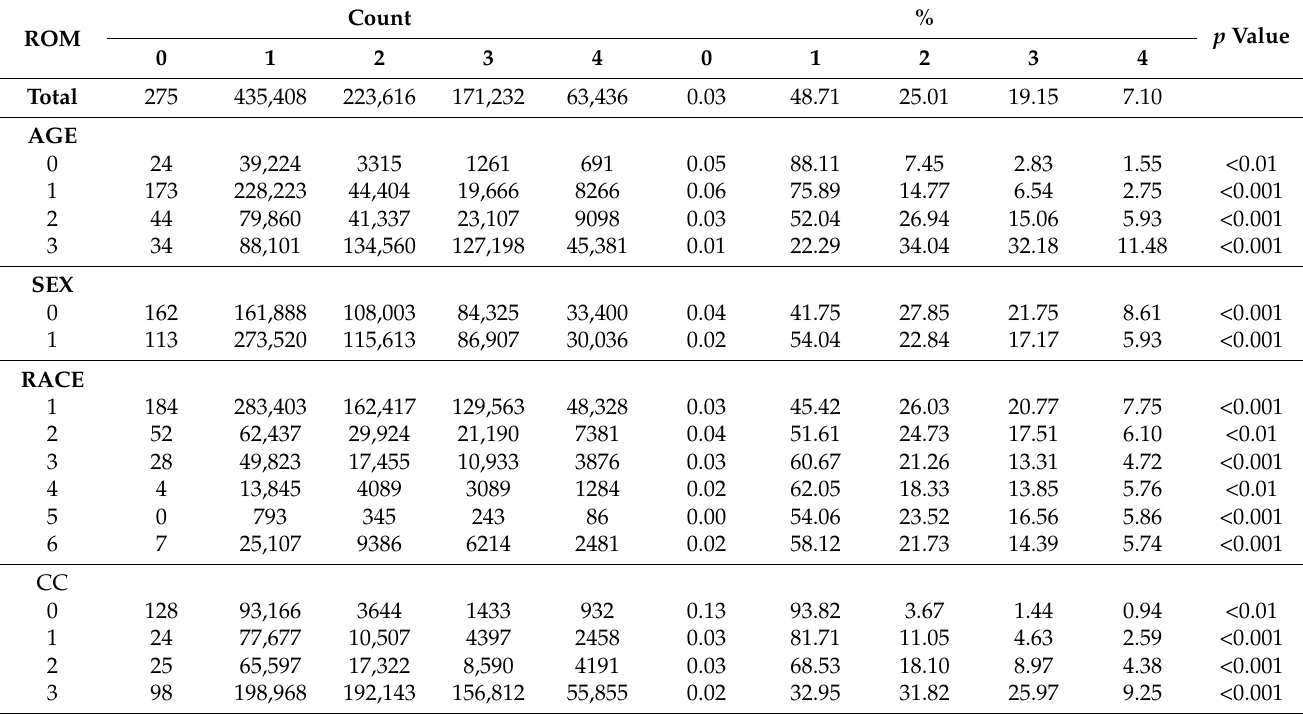
Table 4. The disease severities and the differences in characteristics of patients. Chi-square test is used to calculate p values for differences across disease severity